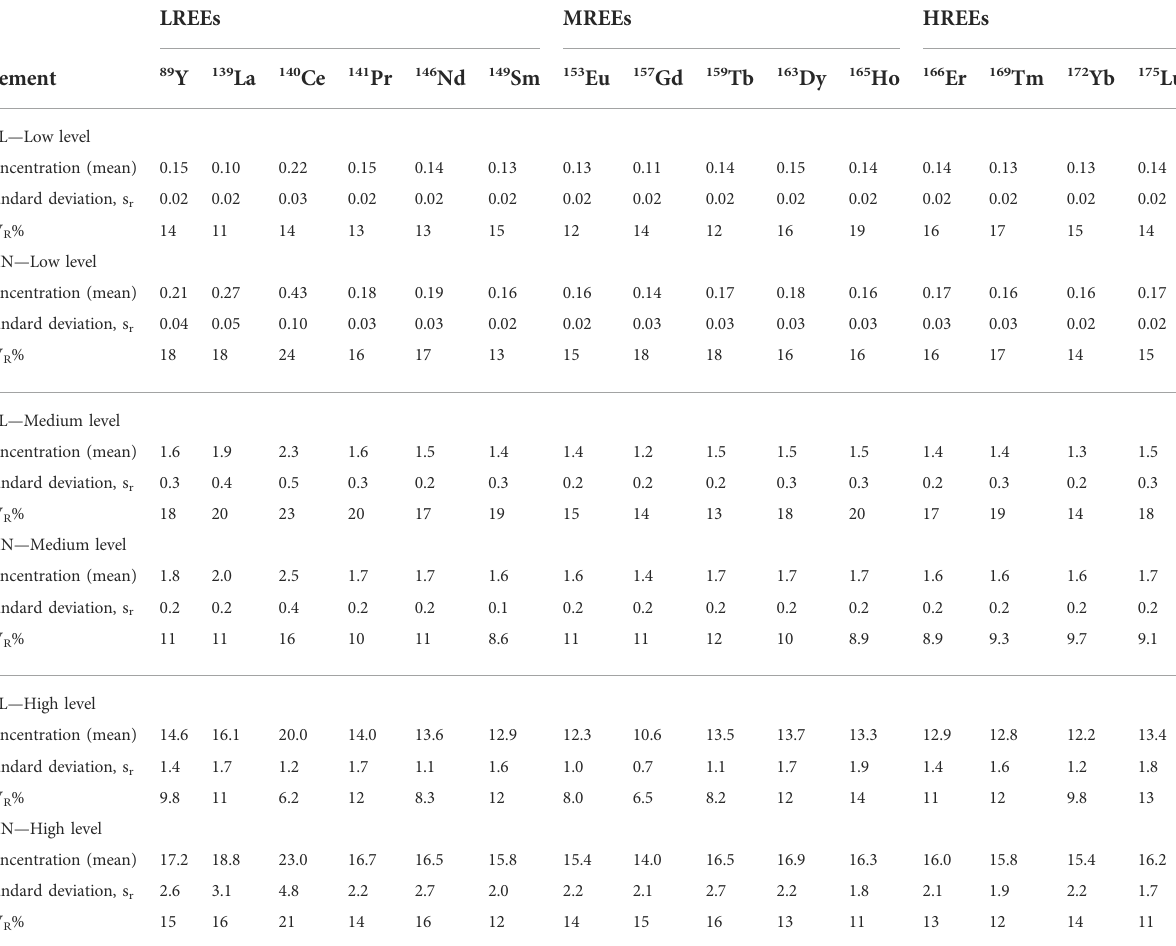
TABLE 5 Resultsof reproducibility precision expressed as standard deviation,s R (µg/L) andrelative standard deviation (CV R %) at three different levels of concentrations (µg/L) for the dilution (DIL) and digestion (MIN) sample preparation procedures. LREEs MREEs HREEs